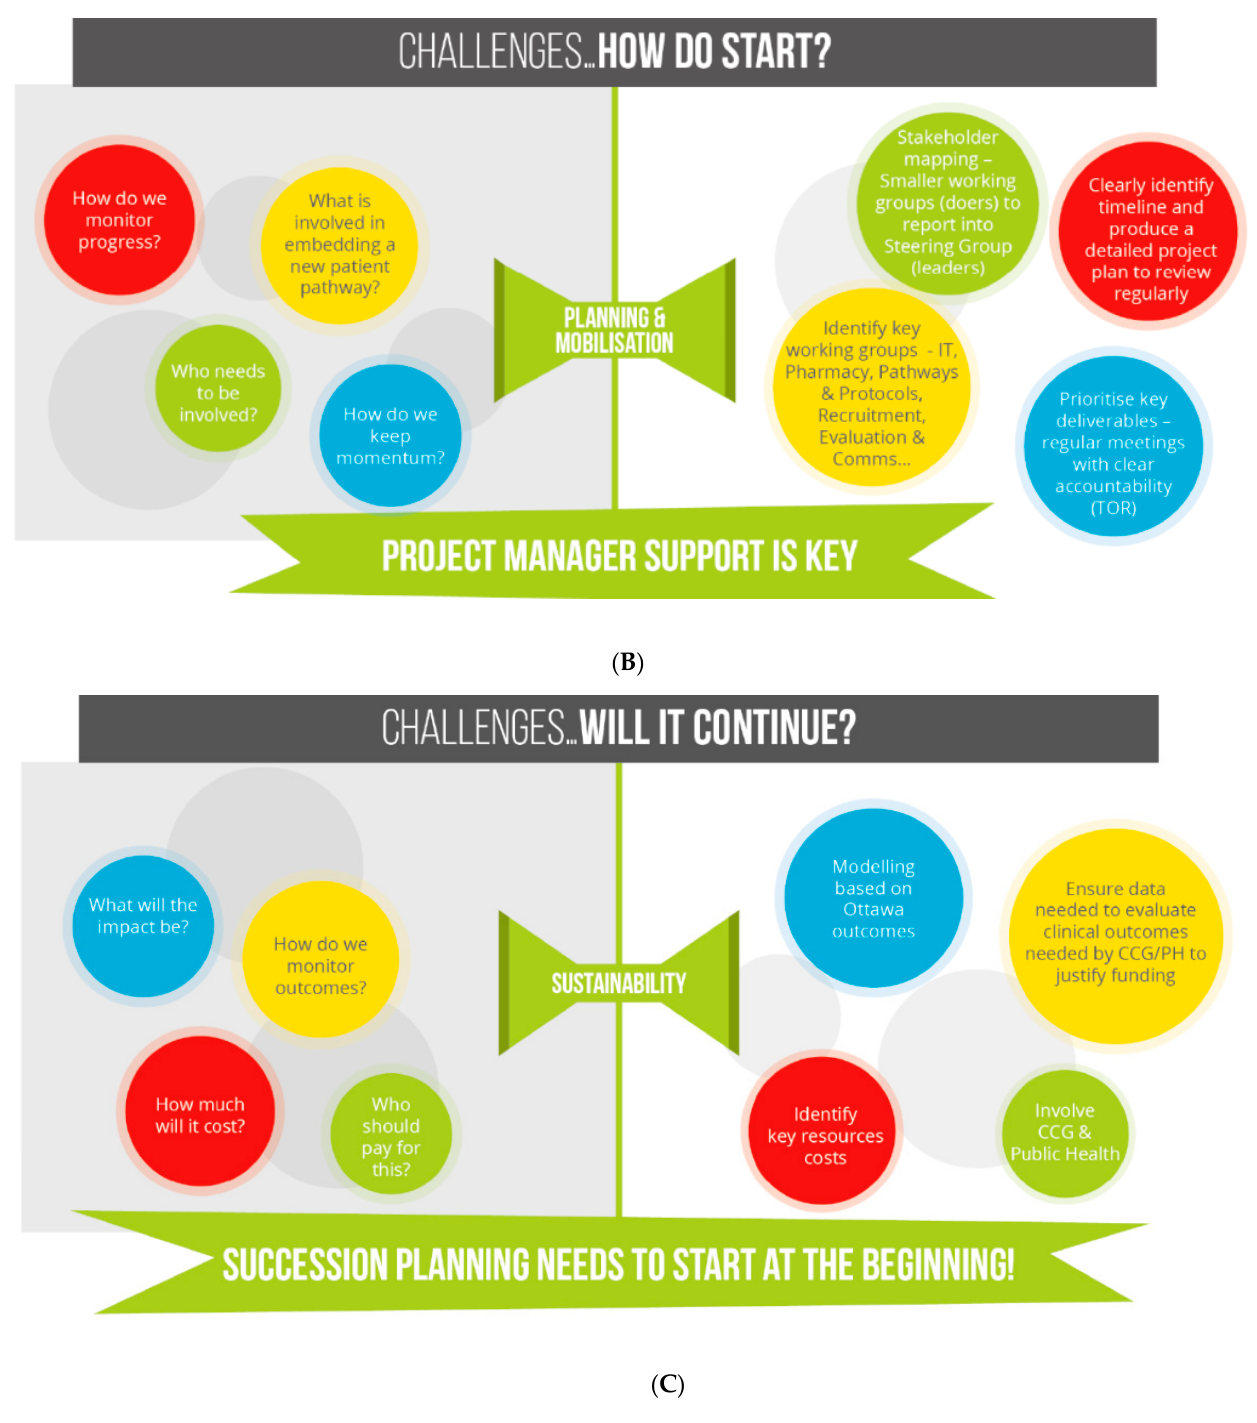
Figure 4. Operational and project management challenges& solutions during the implementation of the CURE Project: ( A ) How do you get people involved? ( B ) How do you start? ( C ) Will it continue?